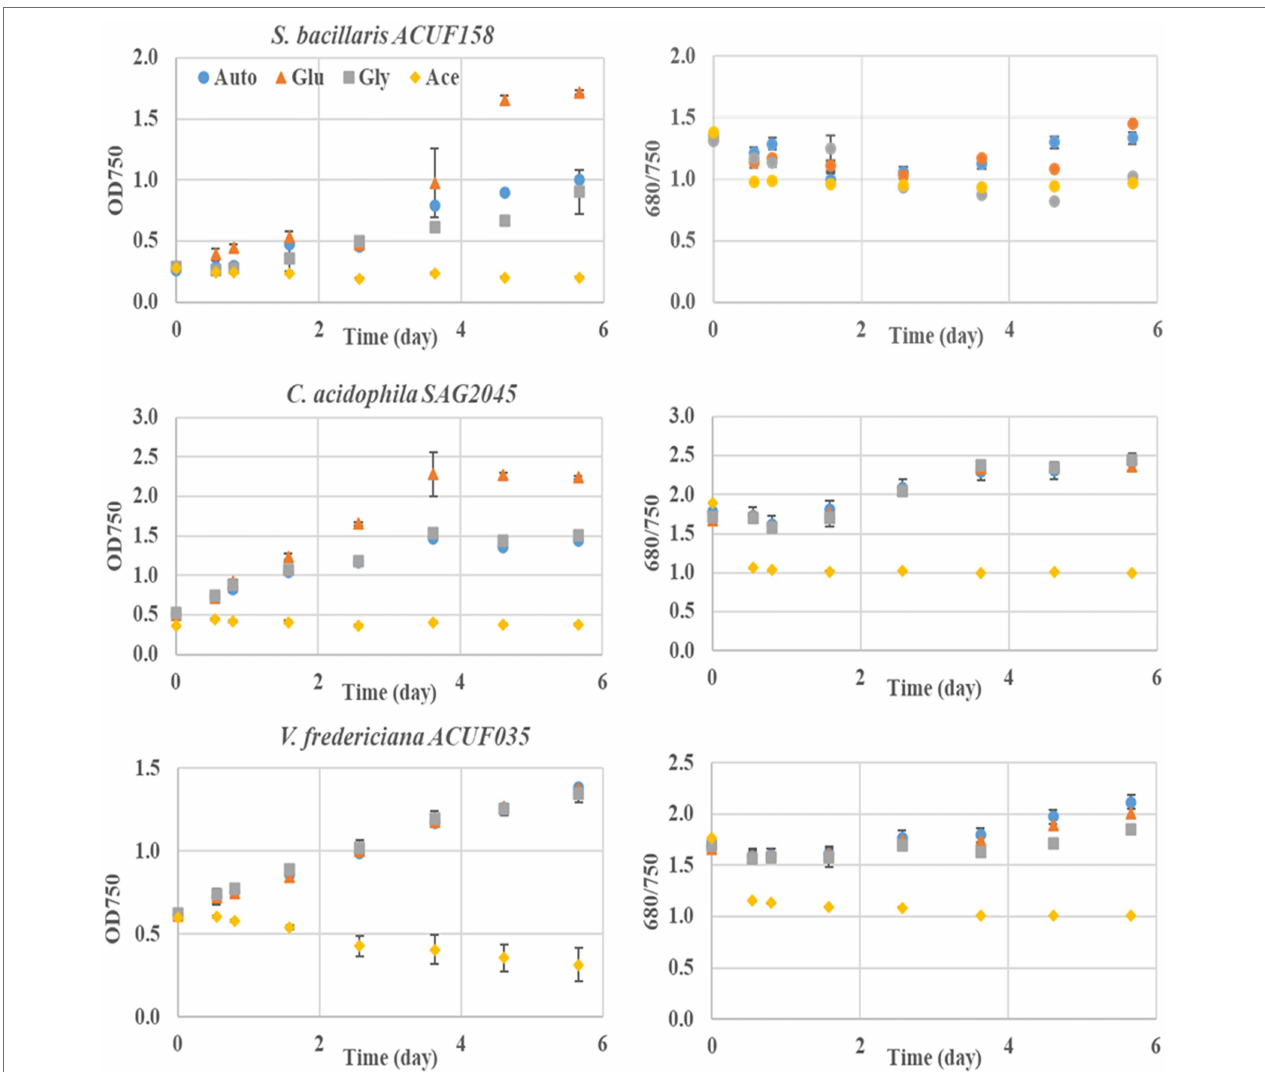
FIGURE 3 | Mixotrophic performance in the presence of 1 g/L of individual carbon source such as glucose (triangle), glycerol (square), and acetic acid (diamond) of three acid tolerant microalgal cultivated at pH 2.9 ± 0.2 strains under 24/24 lighting. An autotrophic culture (dot) is used as